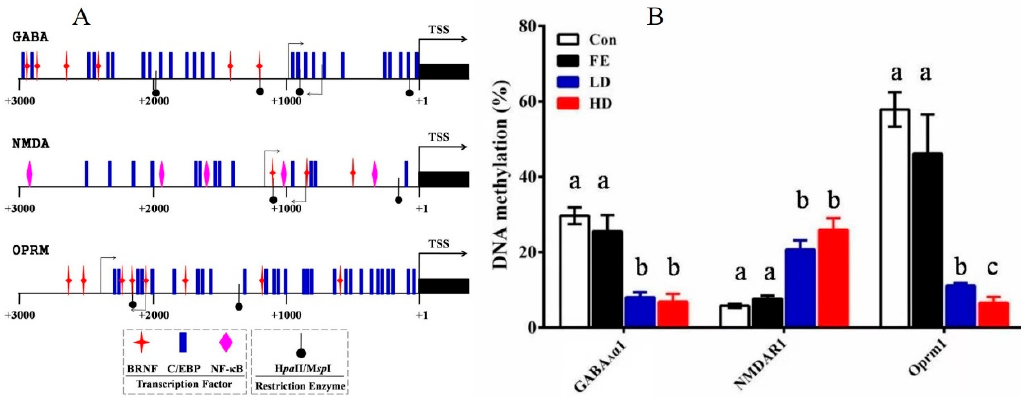
Figure 4. DNA methylation detection in the promoter area of GABA A α 1, NMDAR1, and OPRM1 in the parietal lobe of cerebral cortex samples from rats injected with different medicine. The structure of the primary transcription factor binding sites and DNA methylation positions in the promoter area of the candidate genes. Different symbols are used to indicate the positions of the transcriptional factors and restriction enzymes. The primer pairs used for the methylation assay are denoted by gray arrows ( A ). The detection results of the methylation rates of the GABA A α 1, NMDAR1, and OPRM1 promoter regions. Different colors are used to indicate the different processing methods. The difference was calculated with SAS. The results are expressed as the mean ± SE. Superscripts with different letters indicate significant differences ( p < 0.05) ( B ).